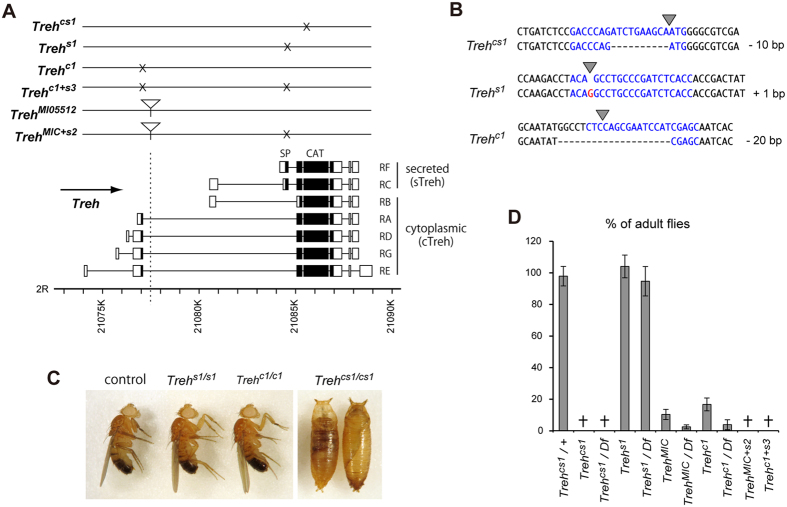
Generation and characterization of the Treh mutants in Drosophila.(A) Schematic representation of the Treh locus and the molecular nature of the mutants. Protein-coding regions and untranslated regions are represented by filled boxes and open boxes, respectively. The P-element insertion sites are marked with an inverted triangle. Each transcript is based on information from FlyBase. (B) Sequences of sgRNA target sites and the deletion/insertion of Treh mutants. The 20 bp target sequence corresponding to each target site is indicated in blue and the cleavage sites of Cas9 are shown as triangles. (C) Trehcs1 homozygous mutants were lethal at the pupal period. Trehs1 mutant adult and Trehc1 escaping adult are shown. (D) Lethality of the Treh mutants. Percentages of the indicated mutant adults were determined based on the ratio of heterozygous mutants in each vial. All the values are means and SD (n > 6 [D]).